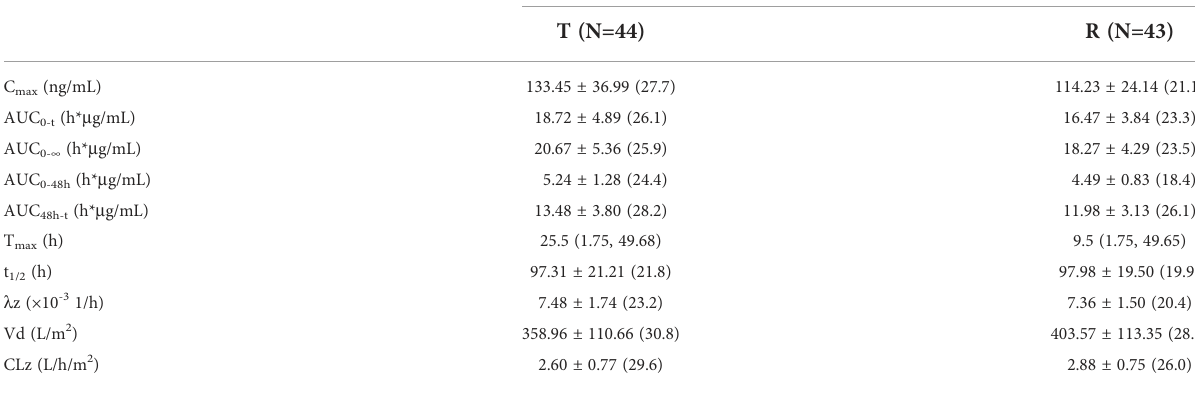
TABLE 3 The PK Parameters of Free Doxorubicin. Parameters